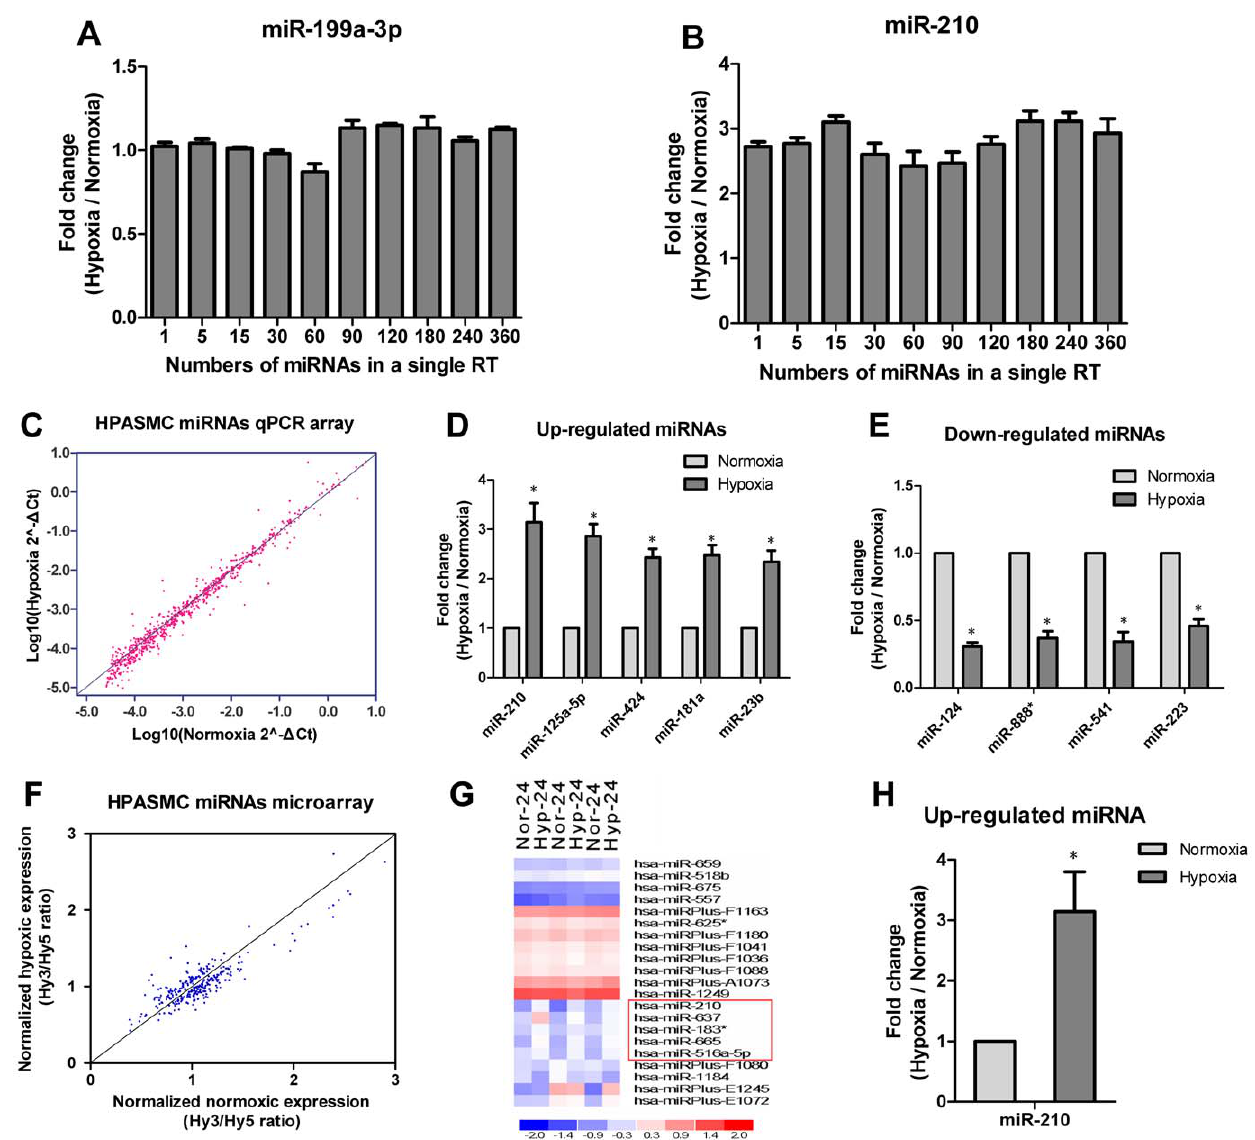
Figure 5. MiRNAs profiling between hypoxic and normoxic HPASMC. A, B: The accuracy for quantification of miR-199a-3p (A) and miR-210 (B) was evaluated in a high-throughput RT reaction. The number of pooled RT primers in a single RT reaction ranged from 1 , 360. C: Scatter plot of relative expression level of 721 miRNAs determined by S-Poly(T) qPCR. The relative expression of miRNA was calculated as 2 ‘ - D Ct and presented in the logarithmic scale. The data on the line across both X and Y axes represented the constitutively expressed miRNAs. D, E: Significantly up-regulated and down-regulated miRNAs. The expression of miRNAs was shown as fold change between hypoxia and normoxia. F: Scatter plot of the relative expression level of 246 miRNAs detected by LNA-based miRNA microarray. The relative expression of miRNA was calculated as Hy3/Hy5 ratio and the data on the line across both X and Y axes represented the constitutively expressed miRNAs. G: Heat map showing the expression of miRNAs that are differentially expressed in hypoxic HPASMC compared with normoxic HPASMC. Red color denotes induction and blue color denotes suppression. H: Significantly up-regulated miRNAs verified by real-time PCR. The expression of miRNAs was shown as fold change between hypoxia and normoxia. Each bar represents mean 6 SD. Statistical significance was determined using two-tailed Student’s t-test. * P ,